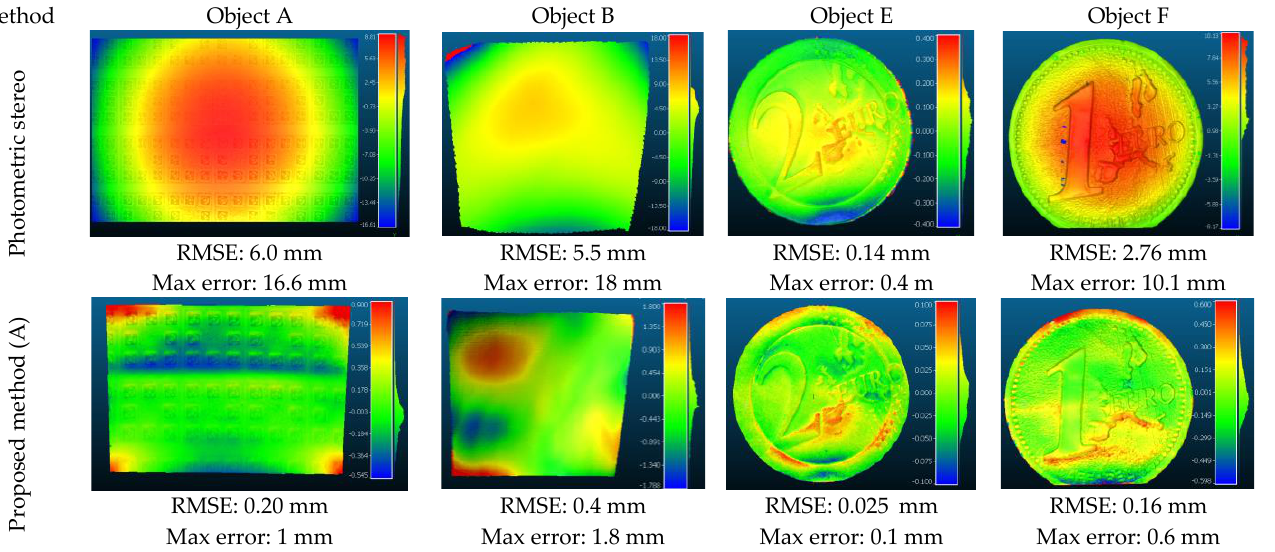
Figure 11. Cloud-to-cloud comparisons with reference data for basic photometric stereo and the proposed method (method A) on objects A, B, E, F.